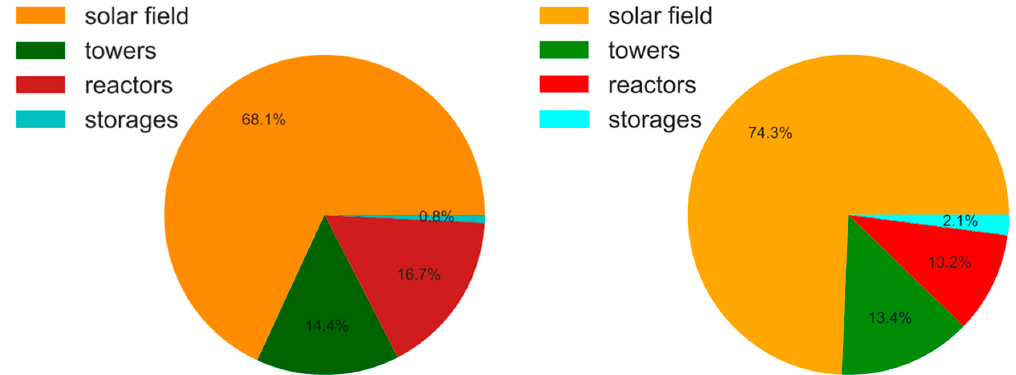
Figure 8. Plant daily performance (ceria, typical day, base case).